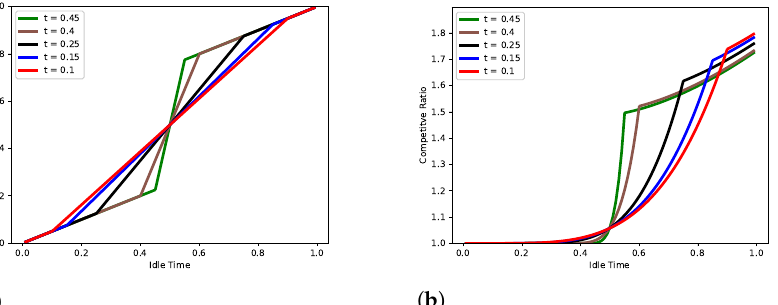
Figure 6. Fixed slope m = 0.50. ( a ) Online strategies for piece-wise linear functions, general system; ( b ) competitive ratios for piece-wise linear functions, general system.